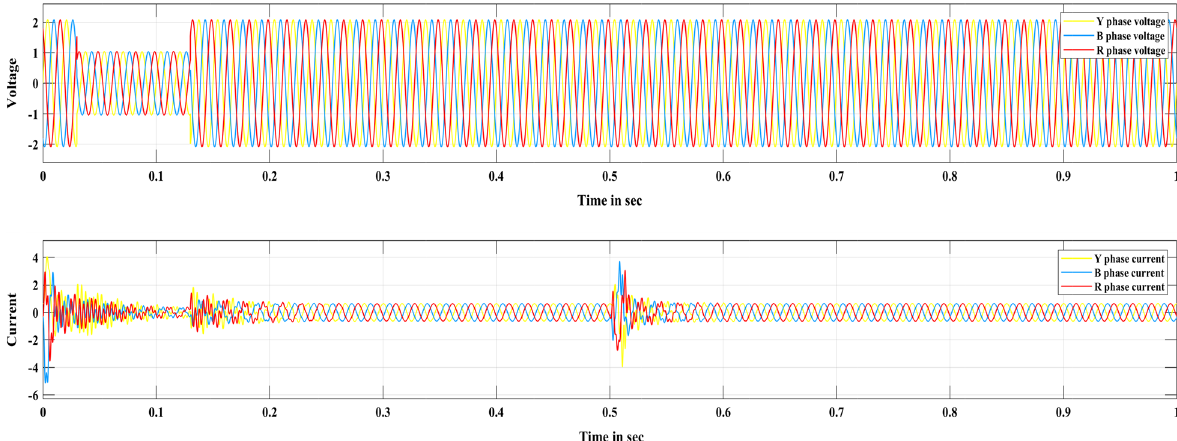
Fig. 13 Voltage and current at rectifier in faulty